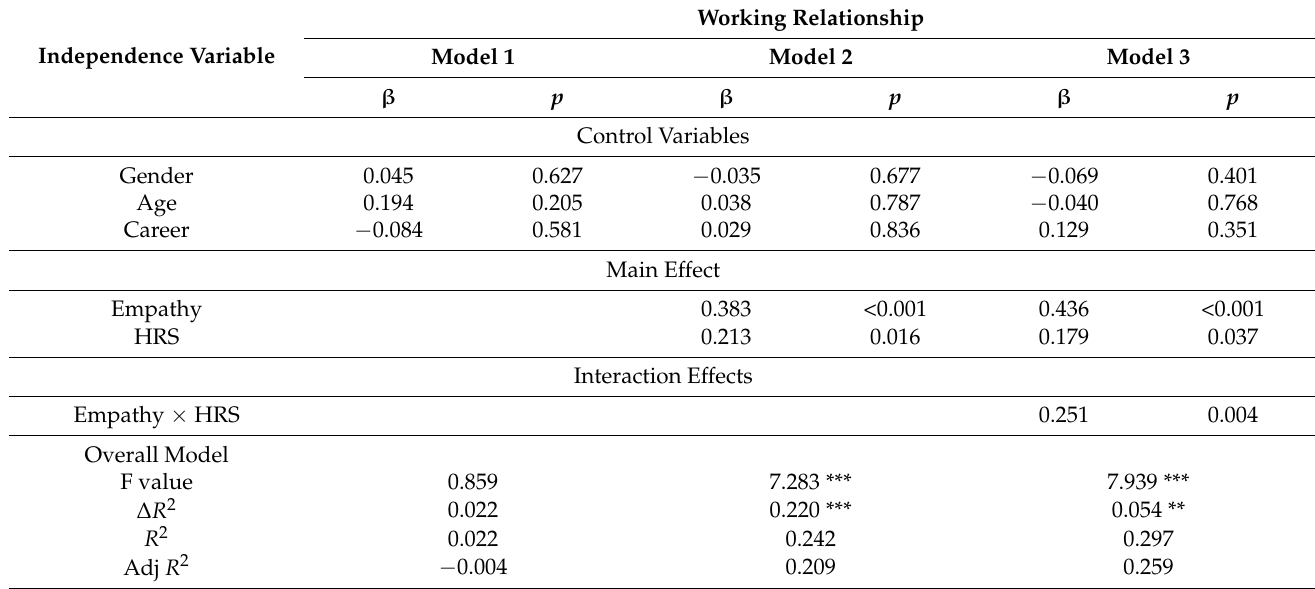
Table 4. Impacts of HRS on empathy and WR with SPR